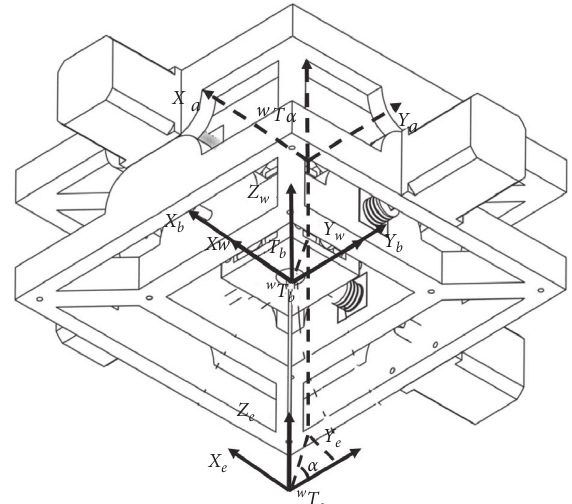
Figure 4: The surgical robot’s coordinate relationship of the ki- nematic model. Define the world coordinate system and the co- ordinate system of each joint to describe the kinematics